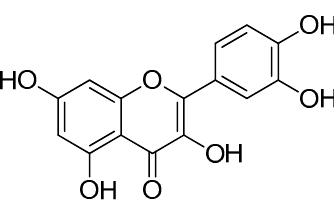
Figure 7. Quercetin. Figure 7.